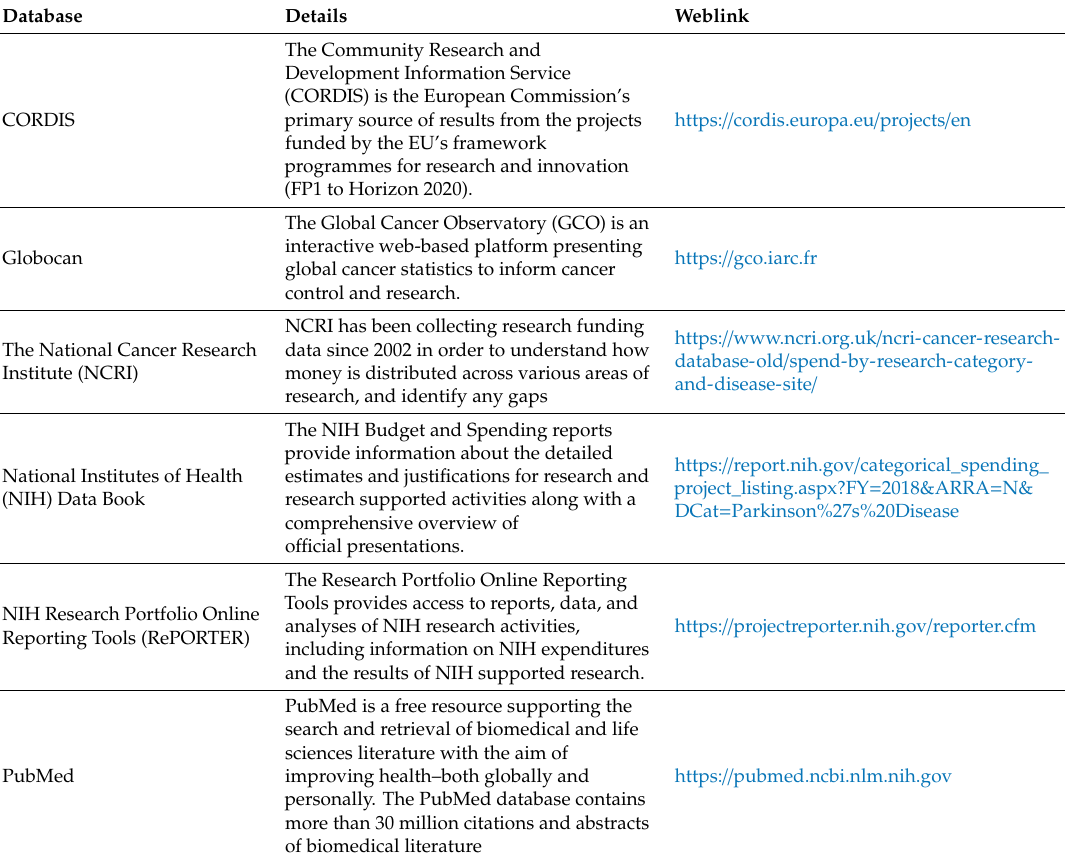
Table 1. Details of the databases used to gather information for this project. These databases are